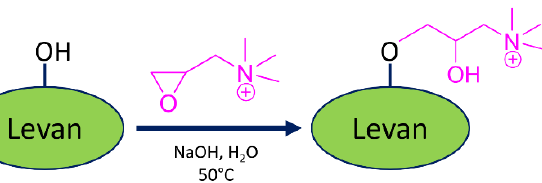
Figure 7. Synthetic scheme for cationized levan using Glycidyl trimethylammonium chloride (GTMAC).